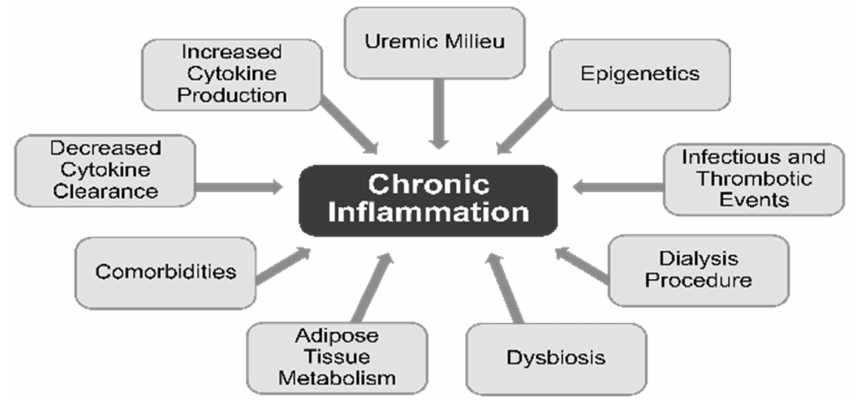
Figure 2. Inflammation in dialysis patients